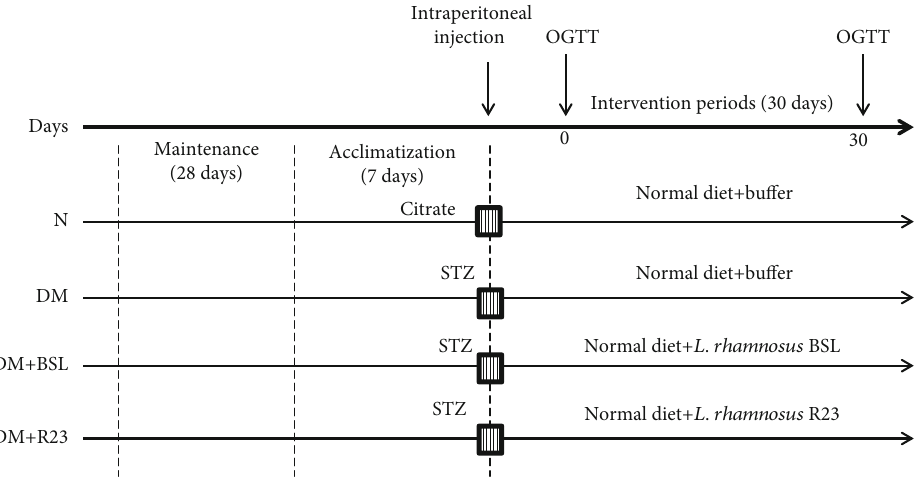
Figure 1: Experimental